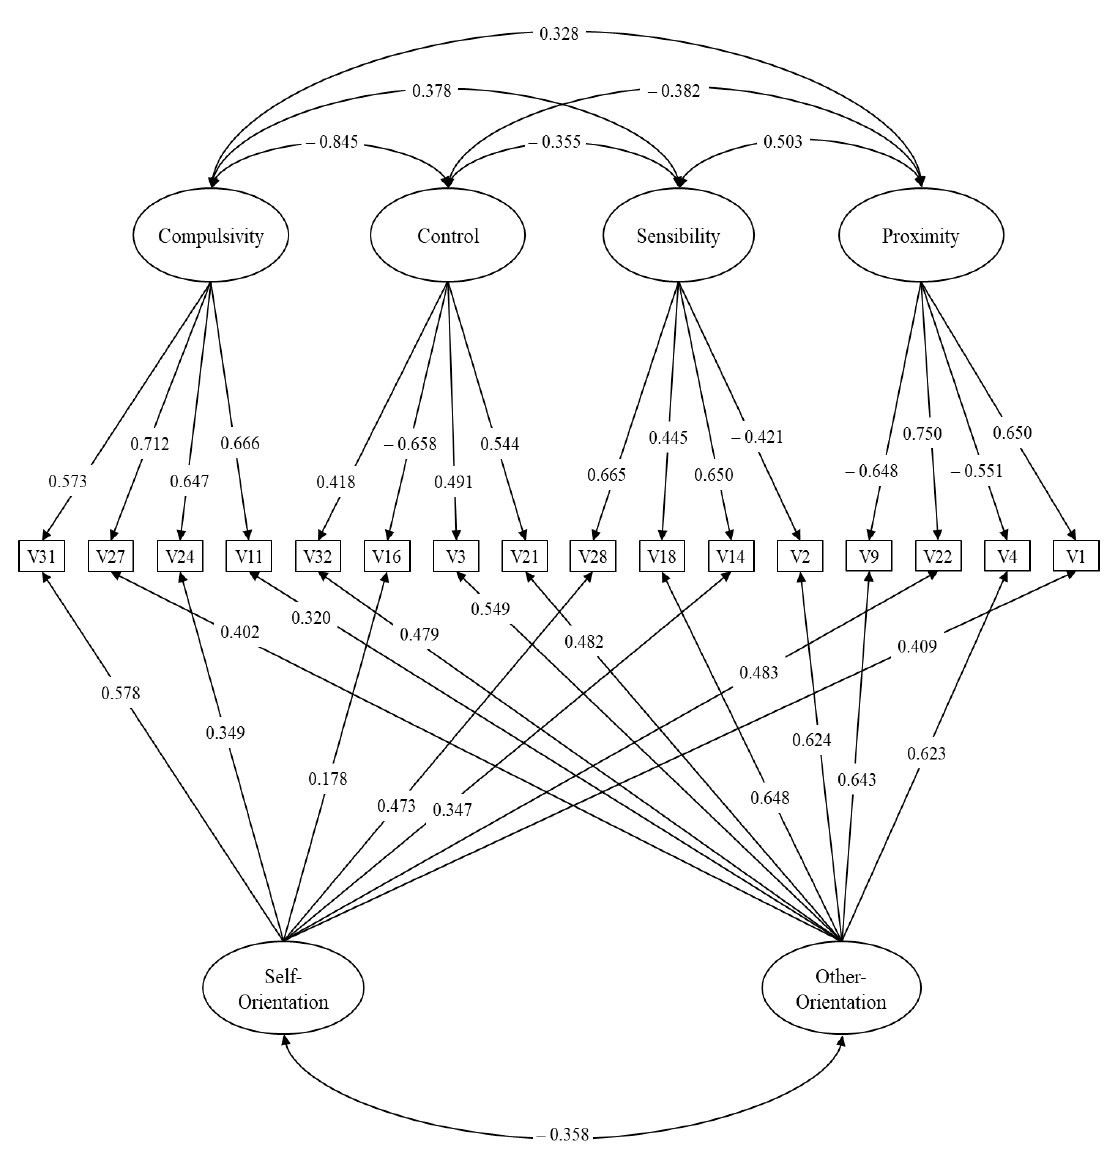
Figure 1. Path diagram of final model of the Caregiving Questionnaire. Table 2. Descriptive statistics and reliability of caregiving factors.